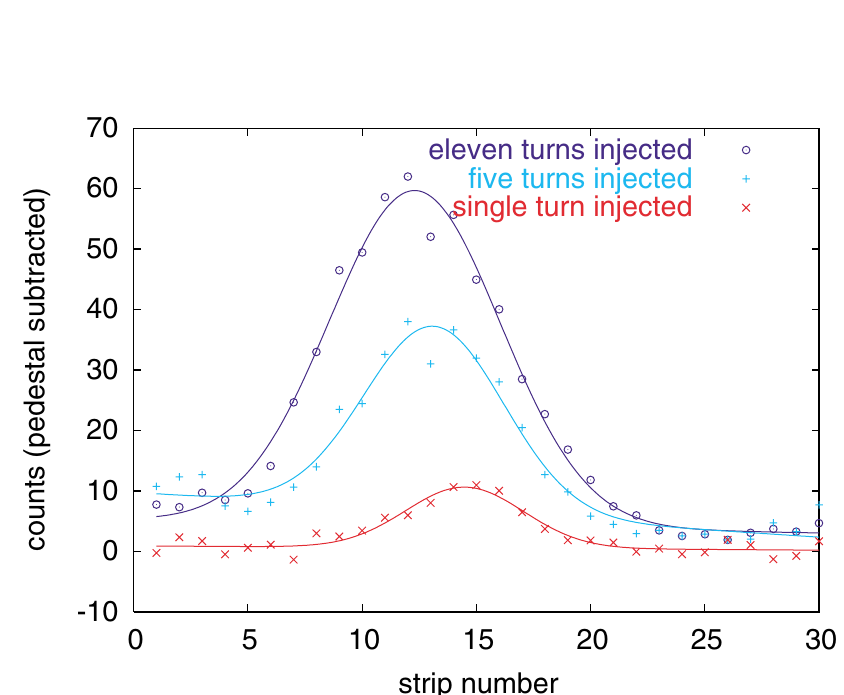
FIG. 5. (Color) IPM measured horizontal beam profiles for a beam charge of one (red line), five (cyan line), and eleven (blue line) injected turns in the machine. The corresponding lines are a fit to the data using a Gaussian plus a first degree polynomial